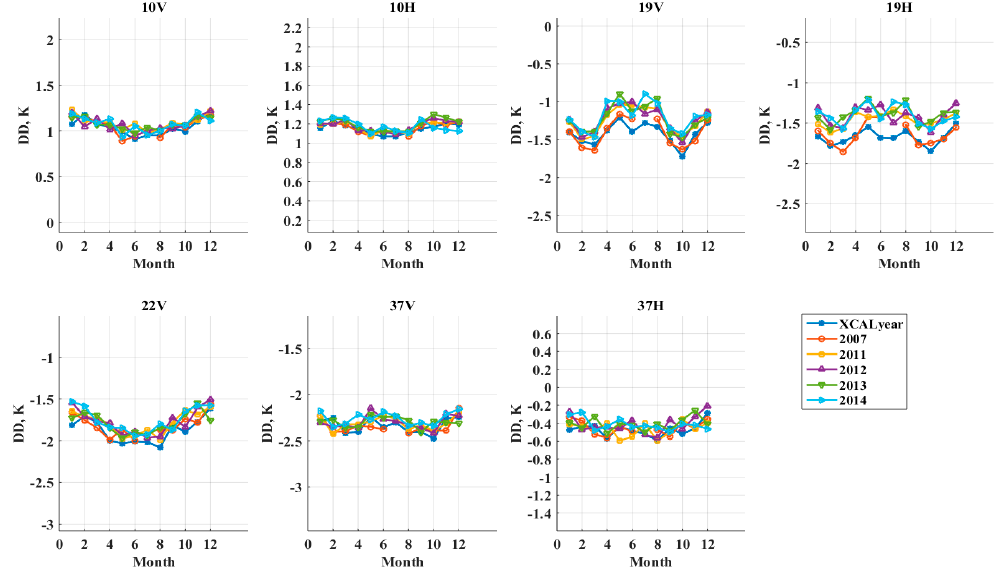
Figure 6. Monthly calibration bias of TMI relative to WindSat for six 1-year durations between 2005 and 2014. XCALyear is 2005 July-2006 June when the GPM Intercalibration (XCAL) Working Group was established.